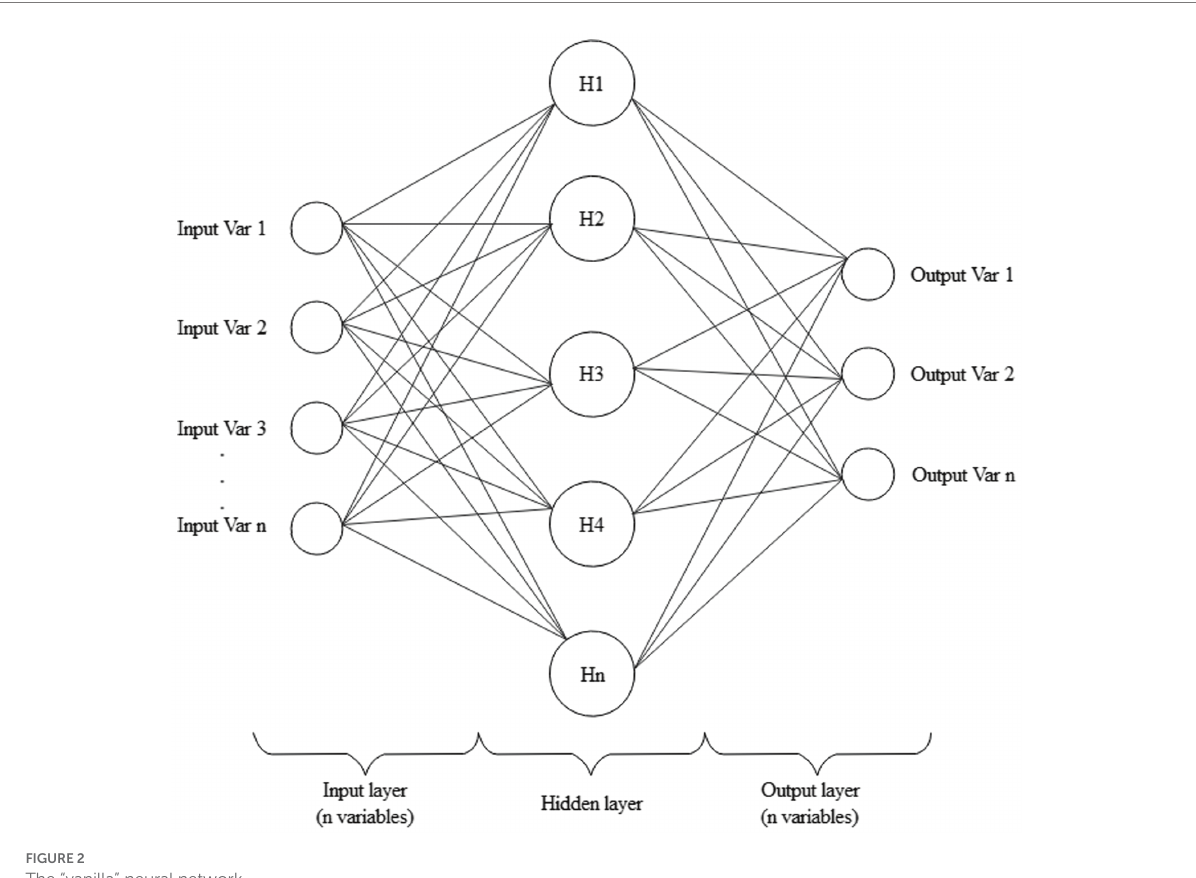
FIGURE 2 The “vanilla” neural